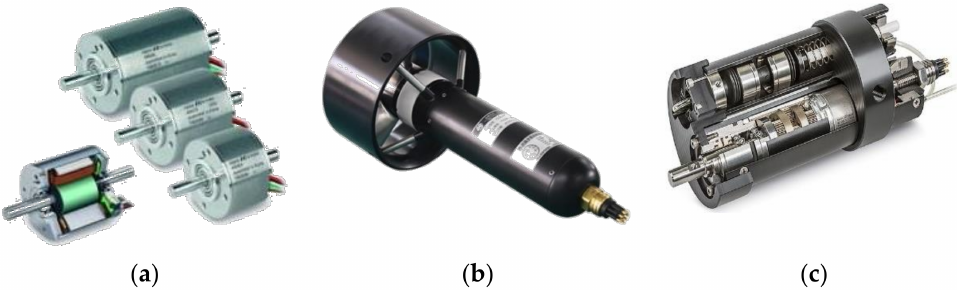
Figure 2. ( a ) Maxon high-torque DC brushless motors for UUVs [8]. ( b ) Underwater thruster propeller motor [9]. ( c ) ECI-40 Maxon underwater drive motor and gear